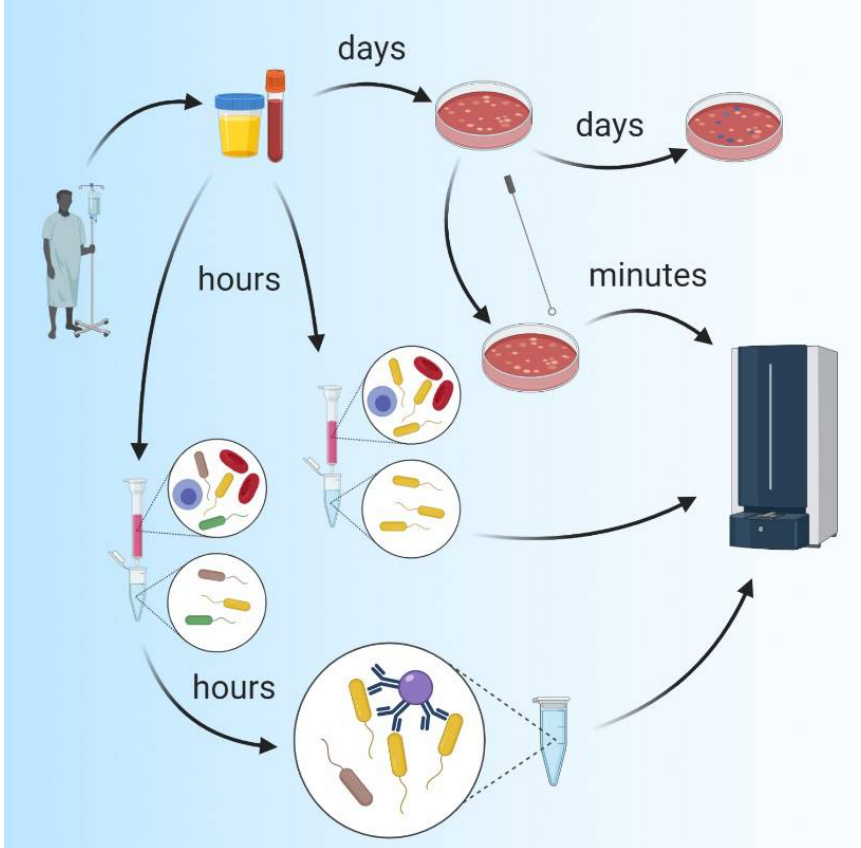
Figure 2. Possible shortcuts for bacterial pathogen identification from patient specimens, using MALDI-TOF MS. Typically, specimens are cultivated and identified via biochemical approaches. By MALDI-TOF-based analysis of single colonies obtained during the first round of cultivation, long turnaround times obligatory for biochemical characterization, can be bypassed. Furthermore, patient specimens can be directly analyzed by purification and concentration of bacterial cells, further shortening turnaround time. However, in case of polymicrobial infections, single bacteria need to be further separated, increasing the time to result. As polymicrobial infections cannot be ruled out in most clinical cases, a further separation of single species should be integrated into routine work- flows.